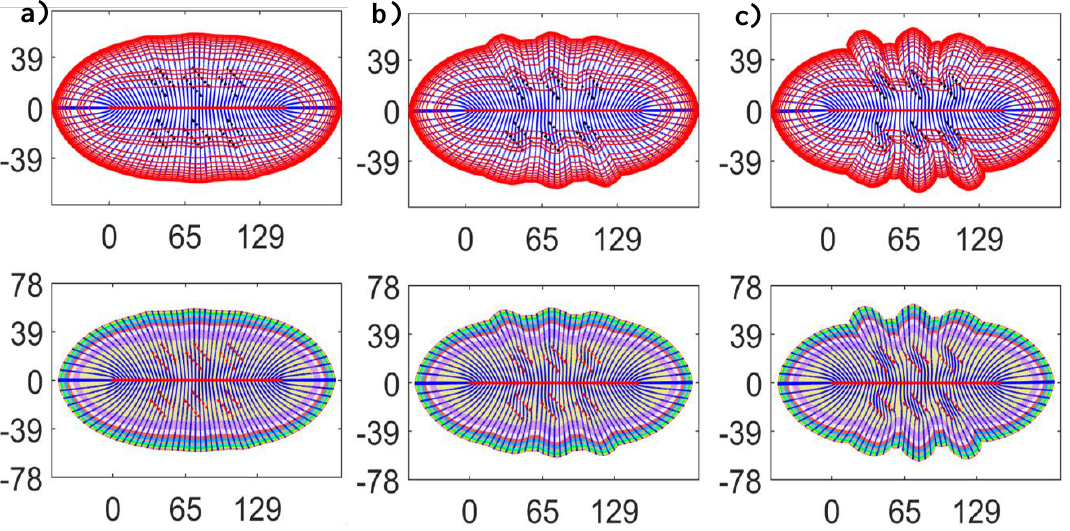
Figure 9. Hydraulic fracture model showing effect of various natural fracture (NF) permeability changes in a reservoir space of 5% porosity with enhanced permeability strengths in the NF of ( a ) 2500 ft 4 /day ( b ) 5000 ft 4 /day ( c ) 10,000 ft 4 /day. Streamlines in blue and TOFC in red. Natural fracture zones in dashed lines and have the same porosity as reservoir. Bottom plots use rainbow colors to show drained areas after 3-year time periods.